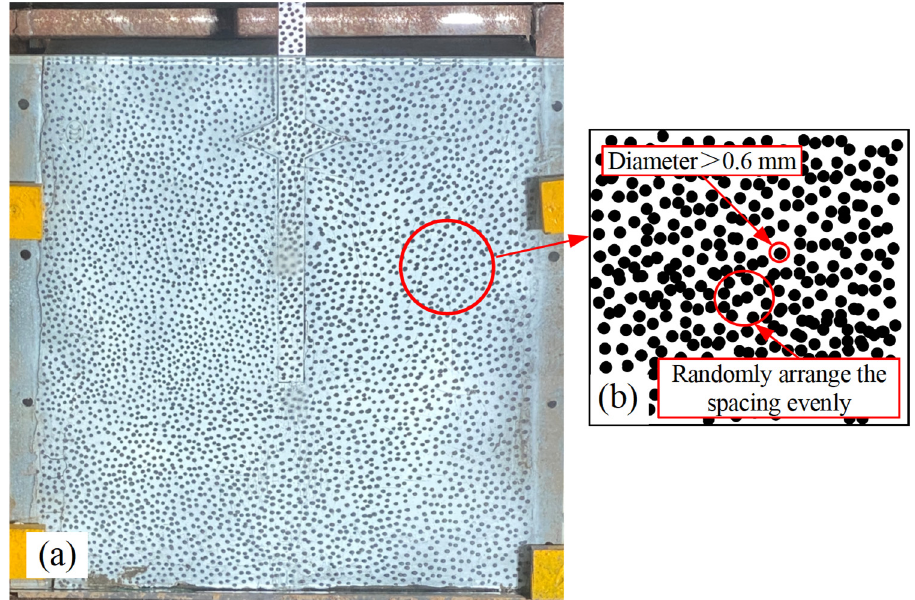
Figure 3. Photo of soil collection surface: ( a ) soil surface with speckles; ( b ) enlarged speckle diagram. Figure 4 indicates the instruments adopted in the testing, including the loading sys-